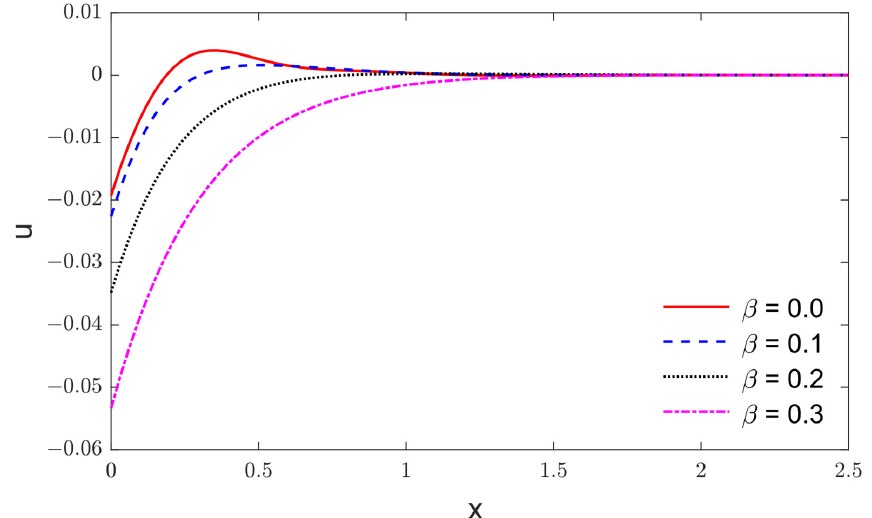
Figure 2. The impact of nonlocal parameter in the displacement variations along the distance x when α = 0.3 and τ o = 0.05 .